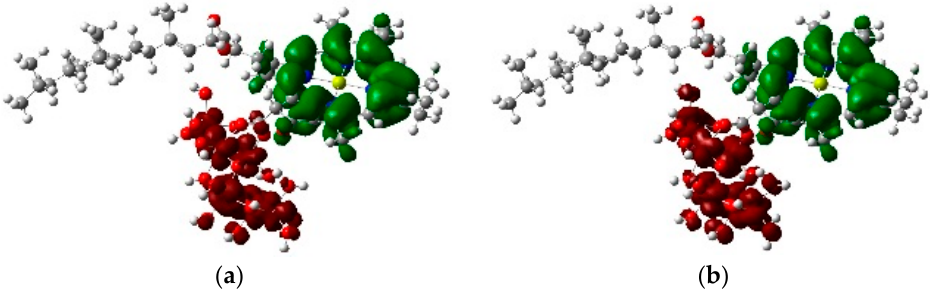
Figure 5 Charge difference density (CDD) for chlorophyll/TiO 2 . ( a ) S6; (b) S9. Figure 5. Charge difference density (CDD) for chlorophyll/TiO 2 . ( a ) S6; ( b )